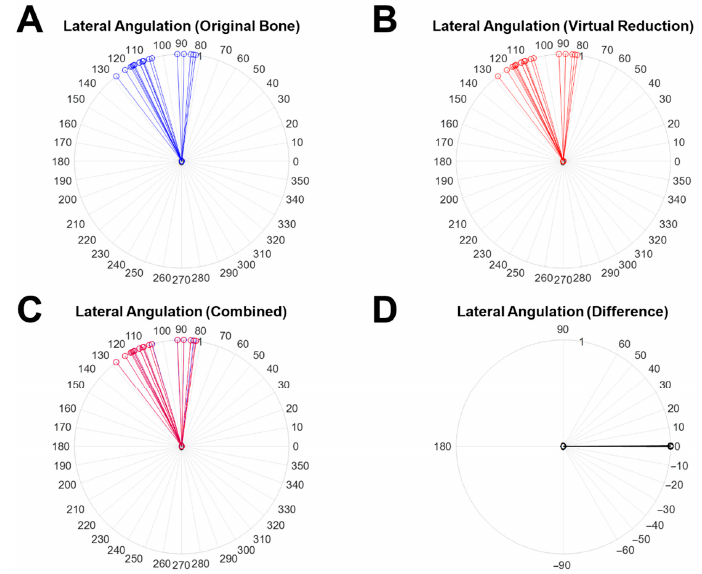
Figure 8. 2D lateral angulation measured on the XZ plane and the variation between the original object and the virtually reduced bone. ( A ) The lateral angulations measured from the angle between Normal Vector 1 and Normal Vector 2 (the original object), ( B ) the lateral angulations measured from the angle between Normal Vector 1 and Normal Vector 2 ′ (the virtually reduced object), ( C ) overlapped results of ( A ) with blue lines and ( B ) with red lines, and ( D ) the difference (black line) in lateral angulation between ( A ) with blue lines and ( B ) with red lines.